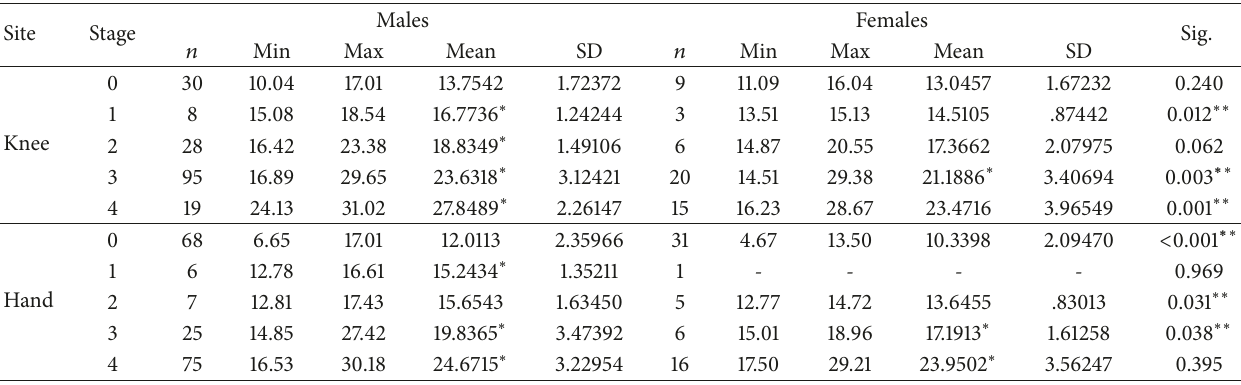
Table 3: Mean, standard deviation (SD), range of age (years), and significance of difference between males’ and females’ ages at each stage of epiphyseal union of the knee joint and hand joints